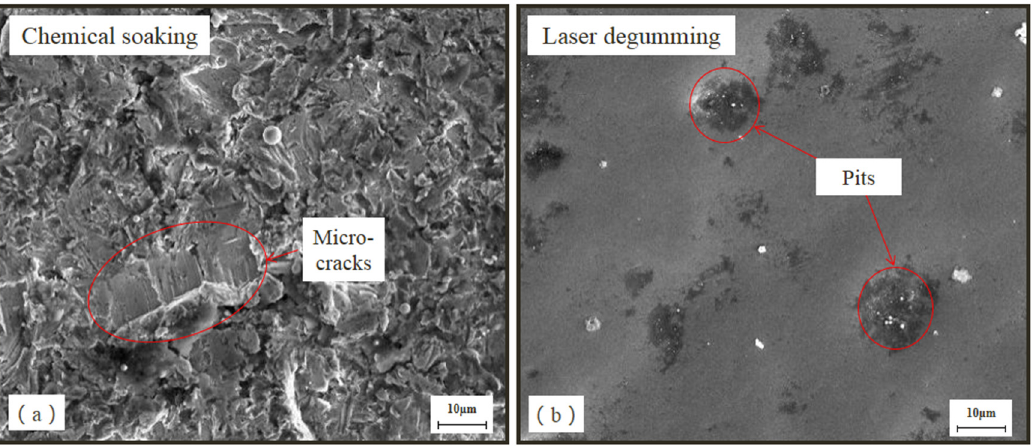
Figure 5. SEM micromorphology of the samples by chemical soaking ( a ) and laser degumming ( b ).